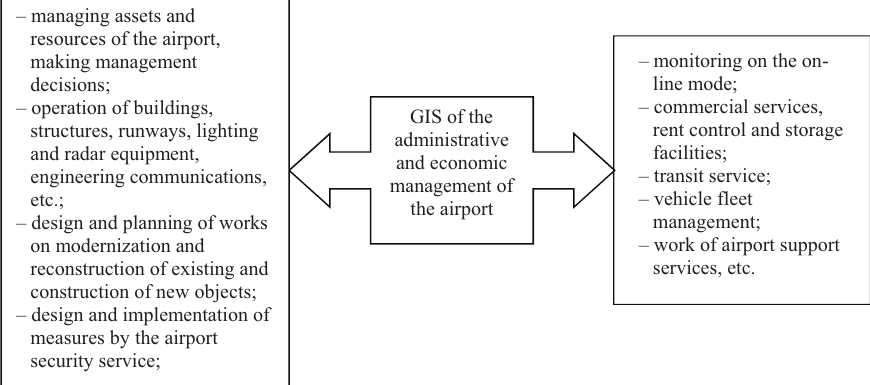
Figure 3. Generalized scheme of directions of application of GIS at airports